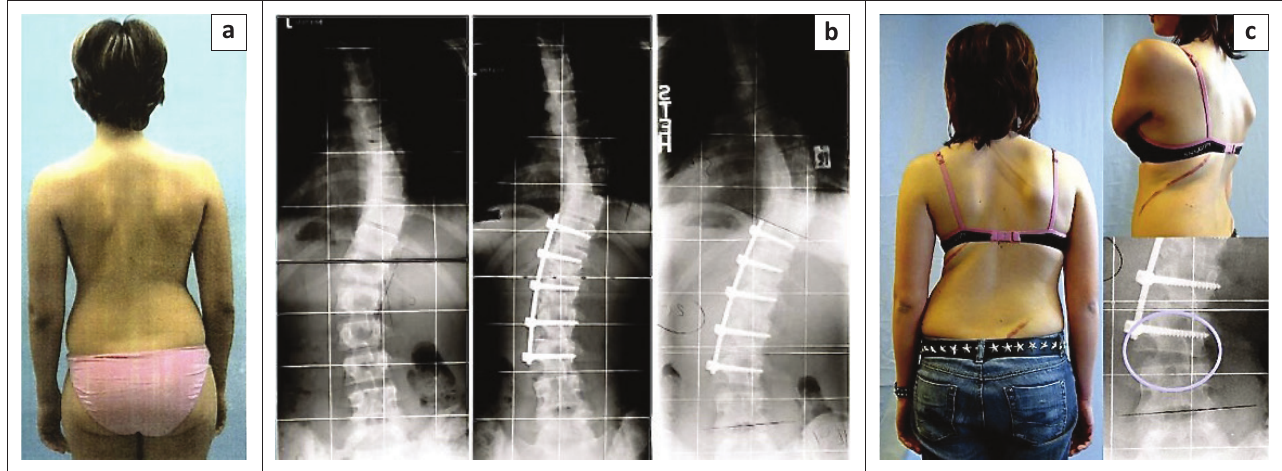
FIGURE 3: (a) 14-year-old, almost fully mature girl with AIS and balanced appearance, (b) native X-ray before and after the operation. (c) Appearance after surgery with clear decompensation and radiologically visible wedge deformation of the intervertebral space below the spinal fusion.